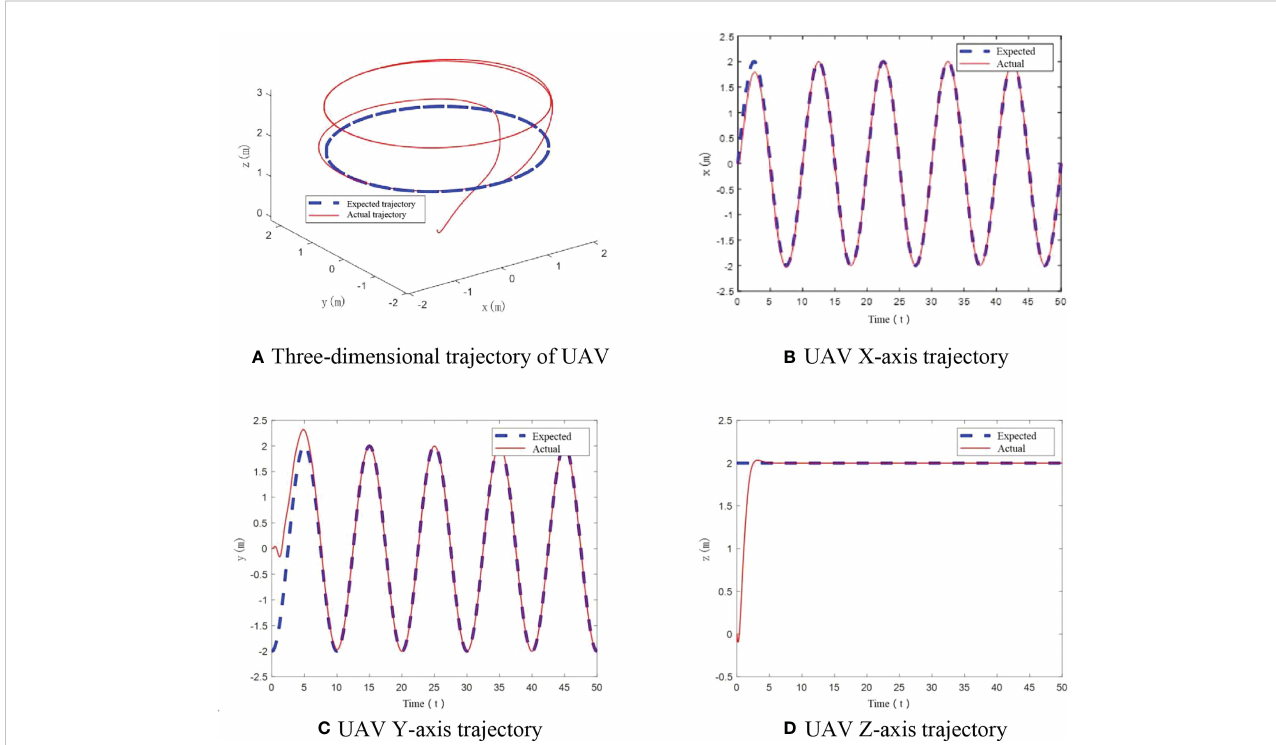
FIGURE 5 UAV fl ight trajectory with no mass change. (A) Three-dimensional trajectory of UAV, (B) UAV X-axis trajectory, (C) UAV Y-axis trajectory, (D) UAV Z-axis